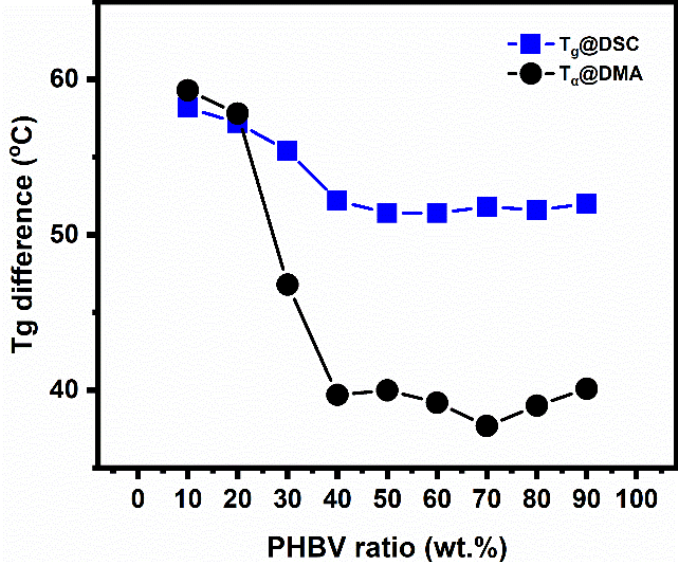
Figure 8. The difference in glass transition temperature values T g between PLA and PHBV.